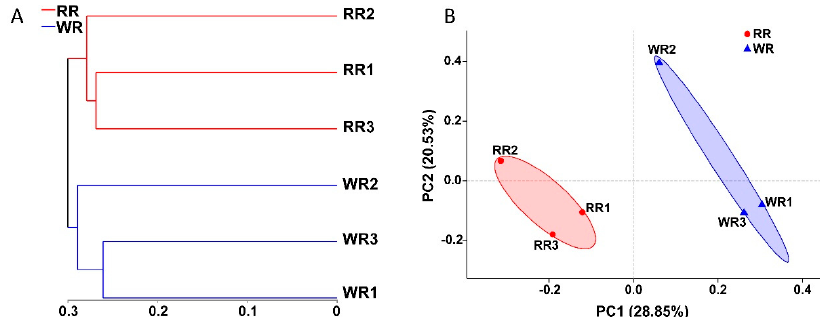
Figure 3. Hierarchical clustering tree ( A ) and principal coordinates analysis (PCoA) results ( B ) for the fungal communities in rhizospheric soil from wild and reintroduced M. sinica at the OTU level using the unweighted UniFrac method (WR1, WR2, and WR3 represent the three replicates of rhizospheric soil samples from wild plants (WR); RR1, RR2, and RR3 represent the three replicates of rhizospheric soil samples from reintroduced plants (RR)).